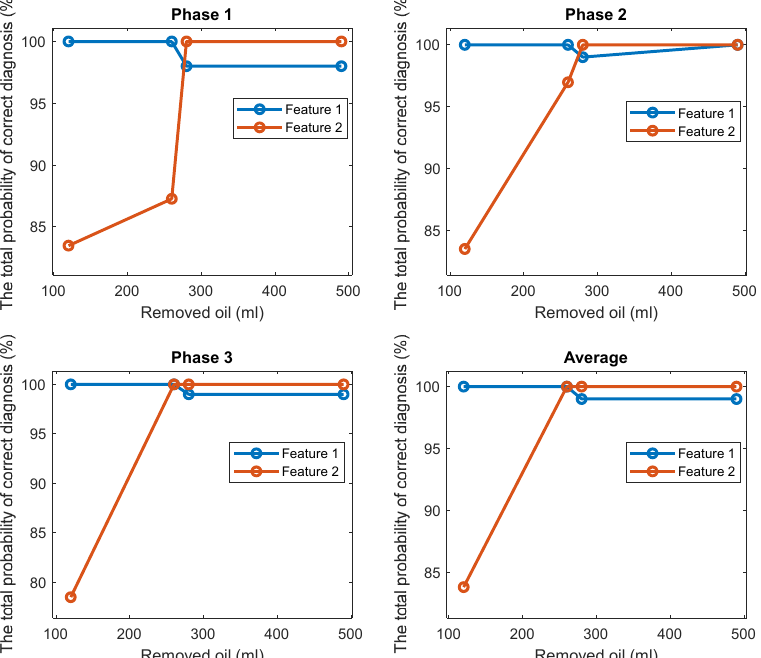
Figure 14. The TPOCD, provided by technology 1 and technology 2, respectively, for three phases and 4 levels of oil removal compared to the standard oil level for Day 1.